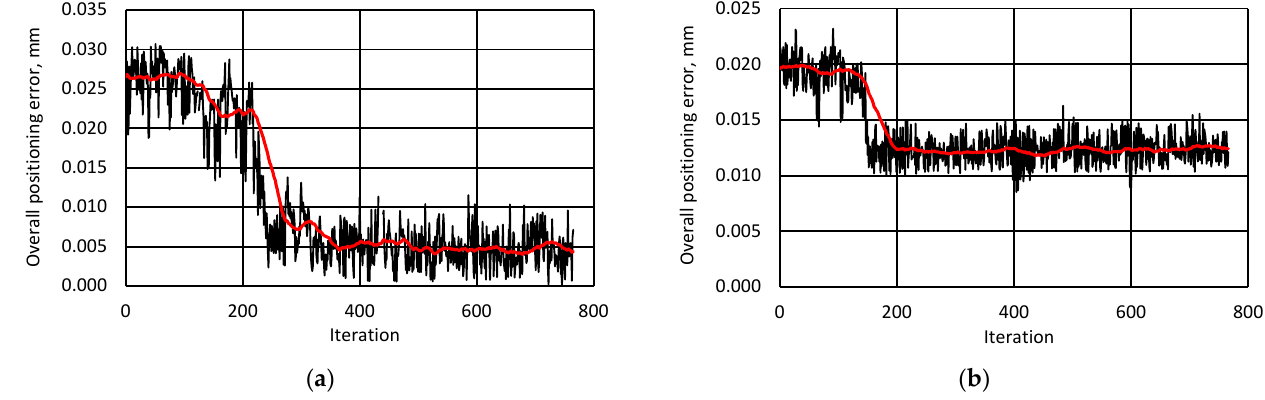
Figure 16. Comparison of robot positioning accuracy before applying correction procedure and after. ( a ) Experiment at the start point (Figure 3a); ( b ) experiment at the endpoint (Figure 3b). The machine learning process was terminated after 780 iterations by the program because the general positioning error stops to decrease. The ML process has different progress for overall positioning error in the start (Figure 3a) and endpoints (Figure 3b) of the trajectory. The learning process at the start point of the trajectory progresses at the 180th iteration, while the process at the endpoint of the trajectory starts approaching the learning target at the 180th iteration and ends at the 240th iteration. Differences in the learning process are influenced by the gravity force depending on the robot links’ configuration.